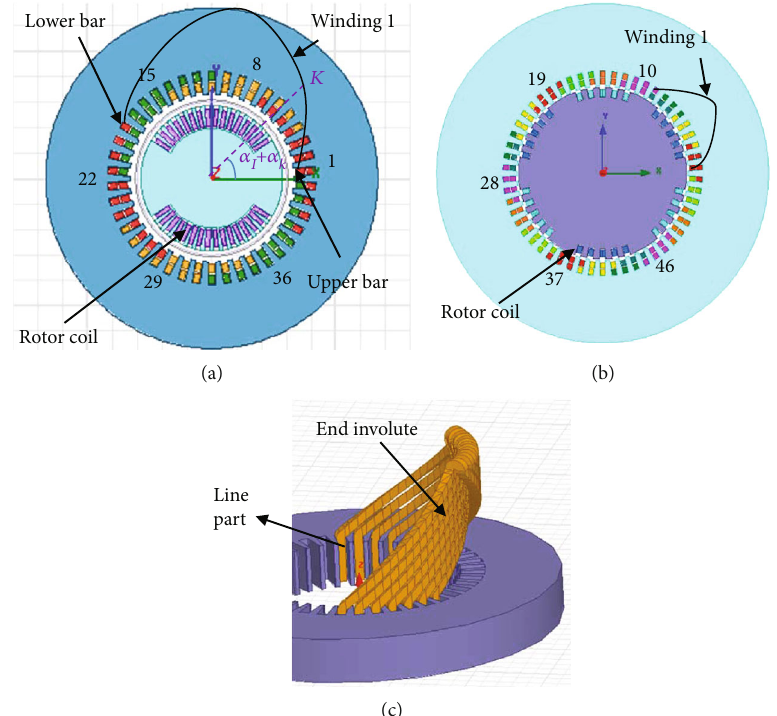
Figure 4: Layout of wingdings: (a) QFSN-600-2YHG generator, (b) MJF-30-6 simulator, and (c) 3D model of stator and